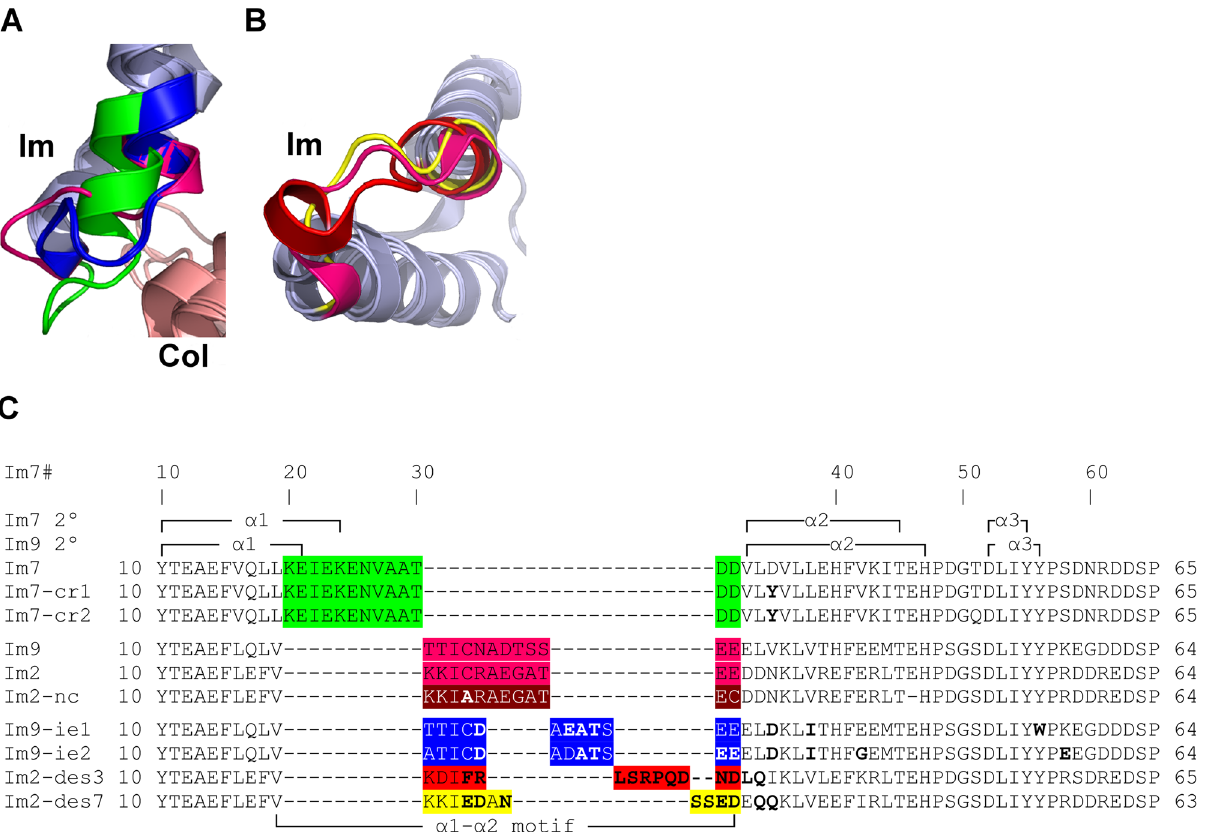
Figure 8. Dissimilar conformations of the α1–α2 motif in the immunity proteins of engineered Im7-like family structures. ( A ) The α1–α2 motifs in the two in vitro evolved immunity proteins (Im9-ie1, Im9-ie2) adopted the same unique conformation. The α1–α2 motifs are colored as follows: Im7, green; Im9, magenta, Im9-ie1 and Im9-ie2, blue. Colicins and immunity proteins are colored pink and light blue, respectively. ( B ) The α1–α2 motifs of the designed immunity proteins (Im2-des3, a “specific” design for Col-des3; Im2-des7, a “multi- specific” variant that recognizes three different designed colicins) adopt different conformations than in Im2. The angle of view is rotated 70° about the X-axis relative to A. The α1–α2 motifs of Im2, Im2-des3, and Im2-des7 are colored magenta, red, and yellow, respectively. ( C ) Structure-based sequence alignment of wild-type and engineered immunity proteins. The α1–α2 motifs are colored as follows: Im7, green; Im9 and Im2, pink; Im2 of a non-cognate pair (Im2-nc), brown; Im9-ie1 and Im9-ie2; blue; Im-des3, red; Im-des7, yellow. Mutations that were introduced into the engineered immunity proteins are marked in bold. Immunity protein positions are numbered according to Im7 (Im7#), shown with the Im7 and the Im9 secondary structure elements above and below the